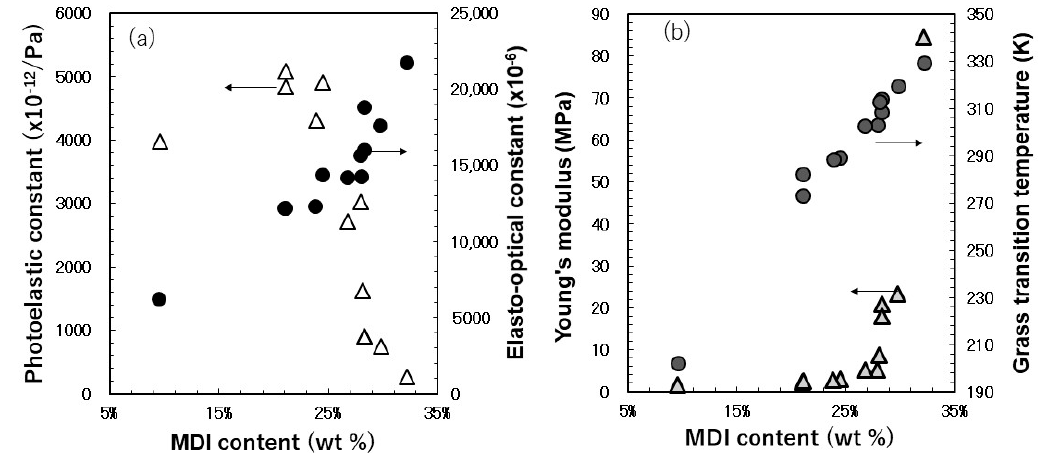
Figure 1. Photoelasticity measurement results of past research: ( a ) relationship between diisocyanate content and photoe- lasticity, and ( b ) relationships between diisocyanate content and elastic modulus and Tg.